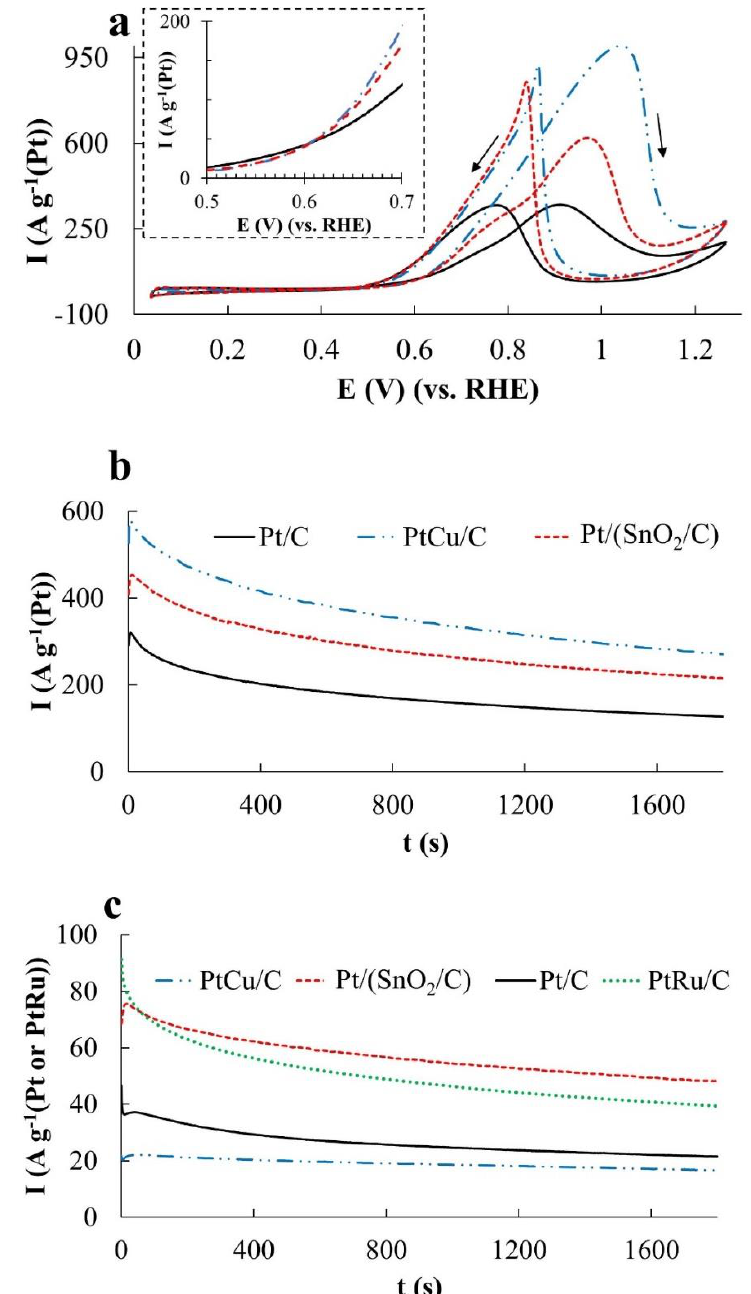
Figure 5. ( a )—Cyclic voltammograms, ( b , c )—chronoamperograms at a potential of 0.87 V ( b ) and 0.60 V ( c ). Electrolyte—0.1 M HClO 4 solution with the addition of 0.5 M CH 3 OH, saturated with Ar at atmospheric pressure.